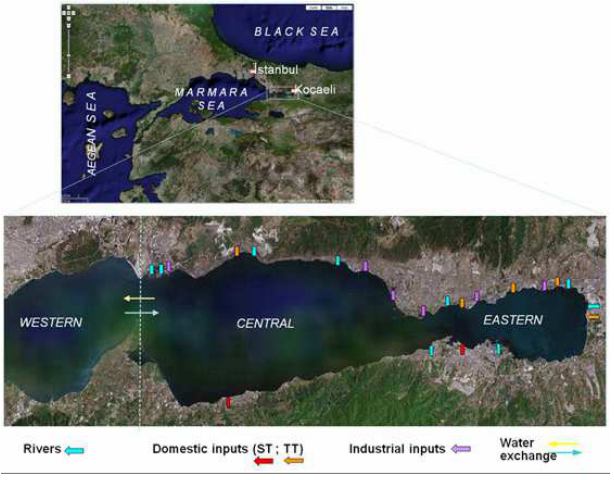
Fig. 1. (Top panel) Location of Izmit Bay (40° 45' N, 29° 56' E) in the Marmara Sea and (bottom panel) the locations of main freshwater input source points (domestic and industrial discharge, rivers, and creeks), and the passage providing water exchange between the western and central basins of the bay. Satellite image was obtained from Google